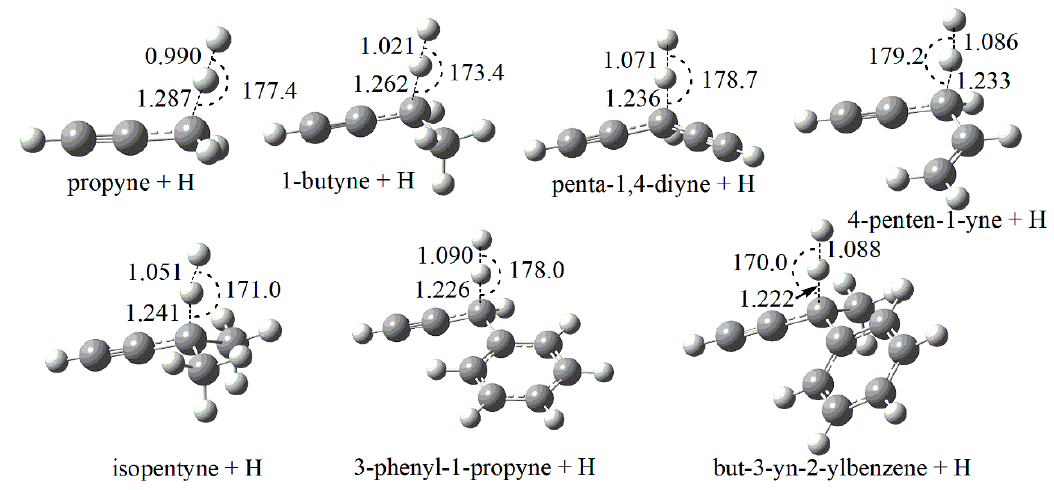
Figure 1. Optimized geometries (in Å and degrees) of TSs for the abstraction reactions by H radical at M06-2X/cc-pVTZ level. The geometry centers of TS for 1-pentyne are identical to that of 1-butyne, and thus not explicitly shown.